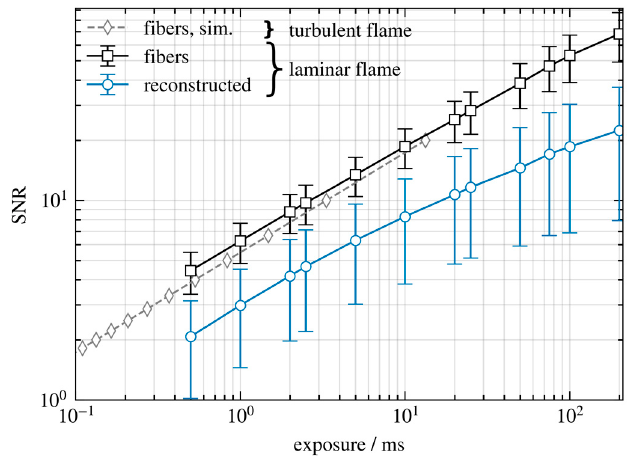
Figure 9. Average signal-to-noise ratio (SNR) of the laminar methane/air diffusion flame in Figure 2, evaluated for the raw fiber signals or radon projections (black squares) and the reconstructed images (blue circles) and as a function of exposure time. The data was recorded 2 mm above the nozzle exit, where the flame is spatially and temporally stable. The gray dashed line is an estimate of the fiber signal-to-noise ratio of the turbulent flame (see text for details).